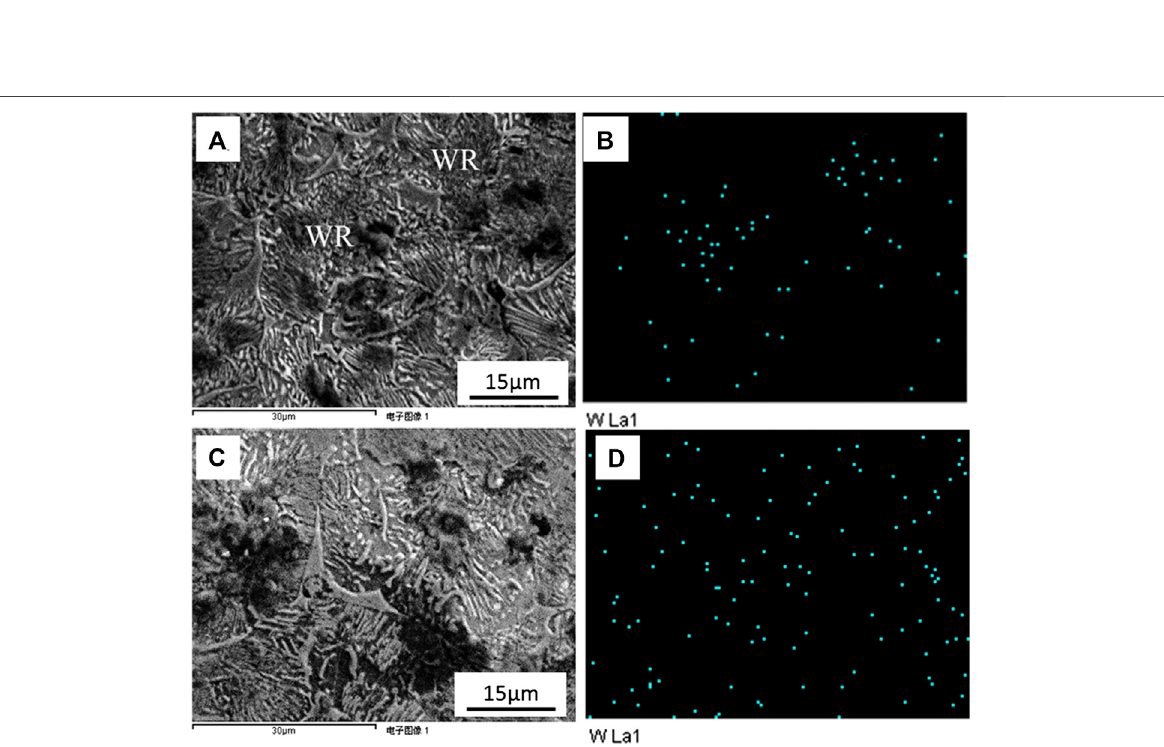
Frontiers in Materials |